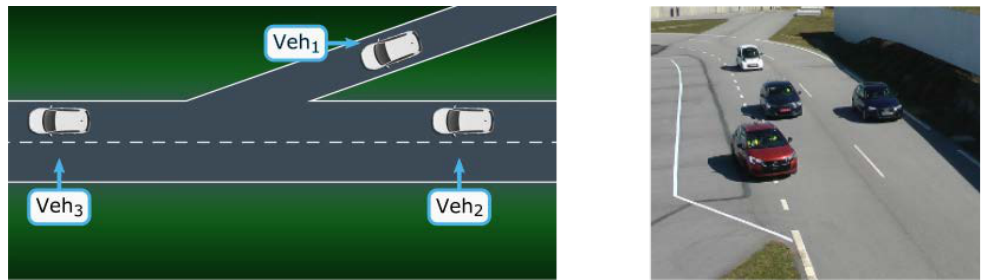
Figure 1. ( Left ) Sketch of the lane merge use case with three vehicles. ( Right ) An example image of this use case recorded on a test track is shown. Here, the red car (Veh 1 ) merges into the tra ffi c on the main road.